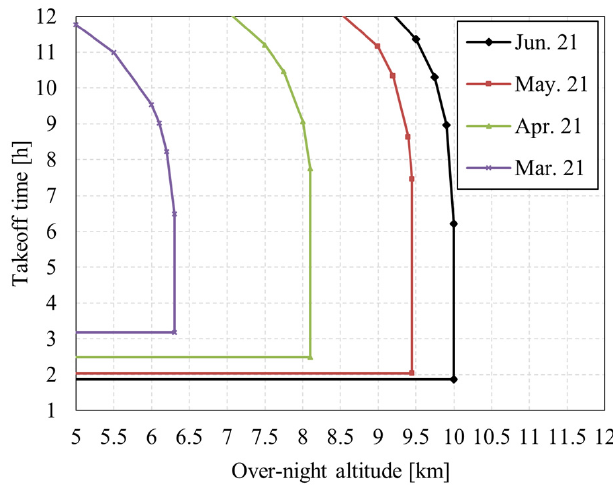
Figure 28. Influence of flight date and overnight altitude on takeoff time window.